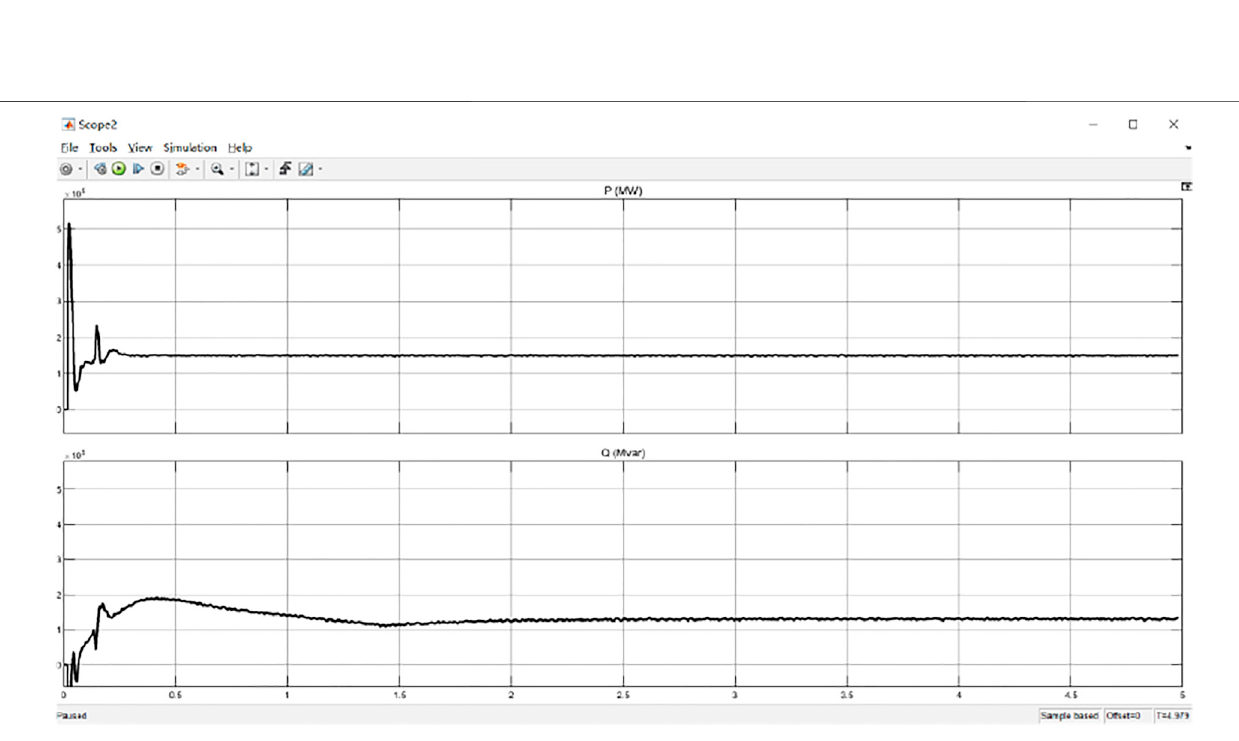
FIGURE 15 | Variation curve of the wind farm power output.